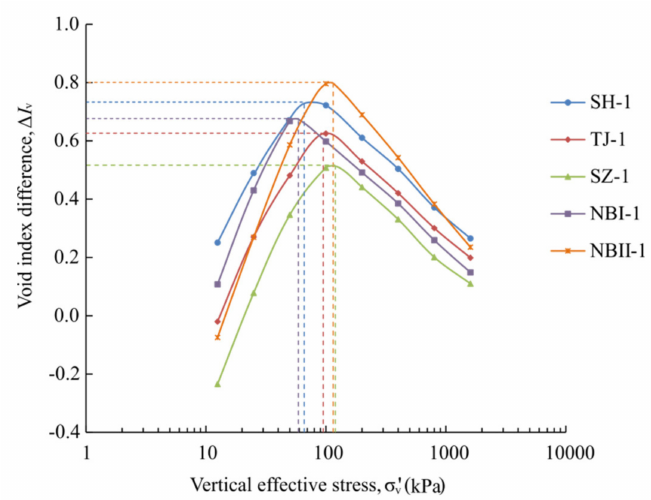
Figure 10. Void ratio di ff erence ∆ I v versus varied vertical e ff ective stress σ v